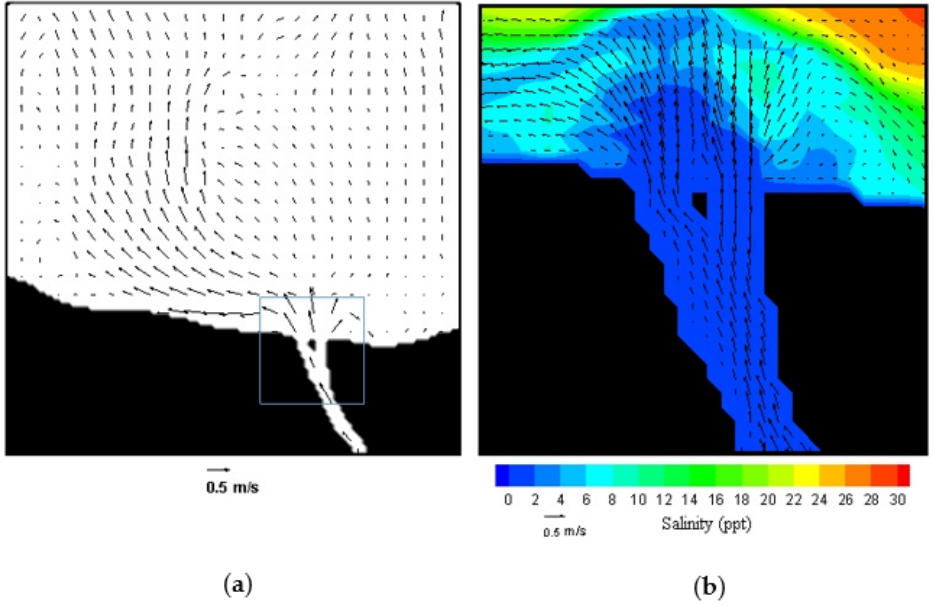
Figure 6. Current pattern at low slack wáter condition (a) model II and ( b) model III.